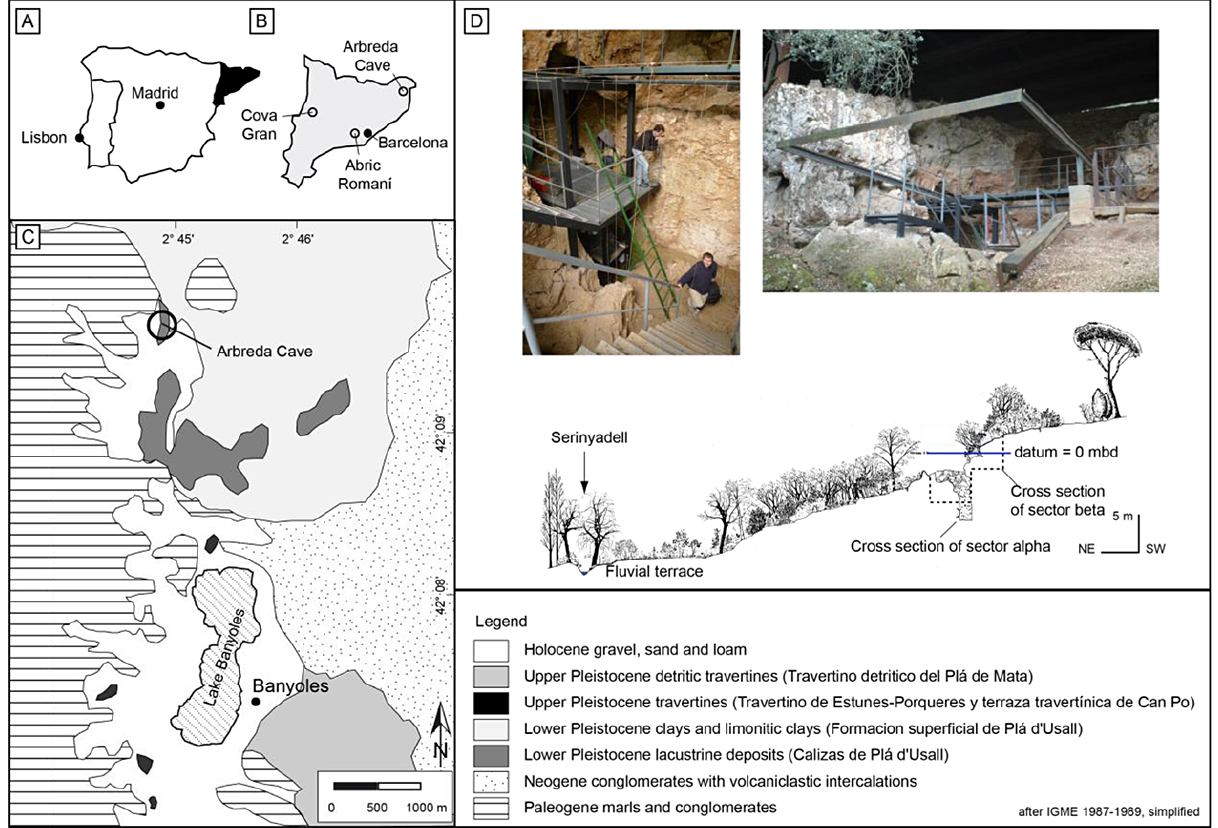
Figure 1. Location of l’Arbreda Cave on the Iberian Peninsula (A, B) , simplified geological map (C) after IGME (1987–1989), photographs of the cave and cross section (after Soler and Maroto, 1987a, changed) through the eastern part of the valley of the Serinyadell River (D) . Note the small altitudinal difference between the river and the lowest sediment fill of the excavation in sector